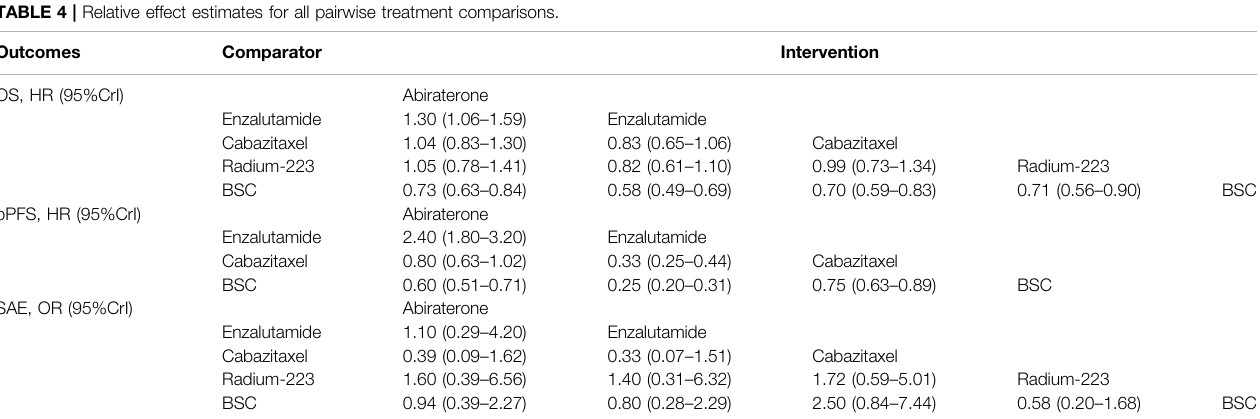
TABLE 4 | Relative effect estimates for all pairwise treatment